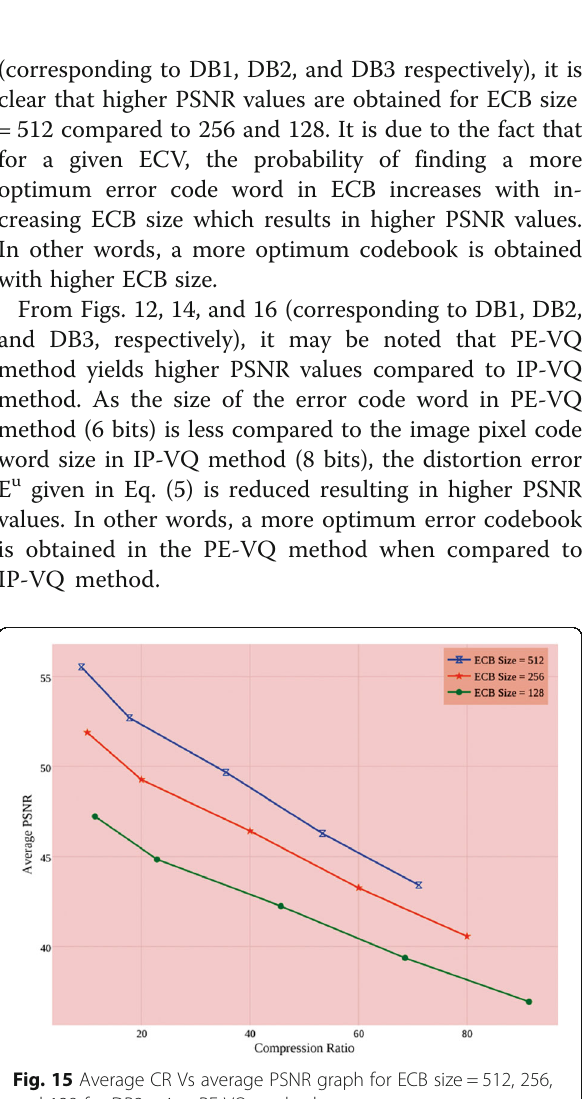
Fig. 16 Comparison of PE-VQ and IP-VQ methods for DB3 with ECB = 256